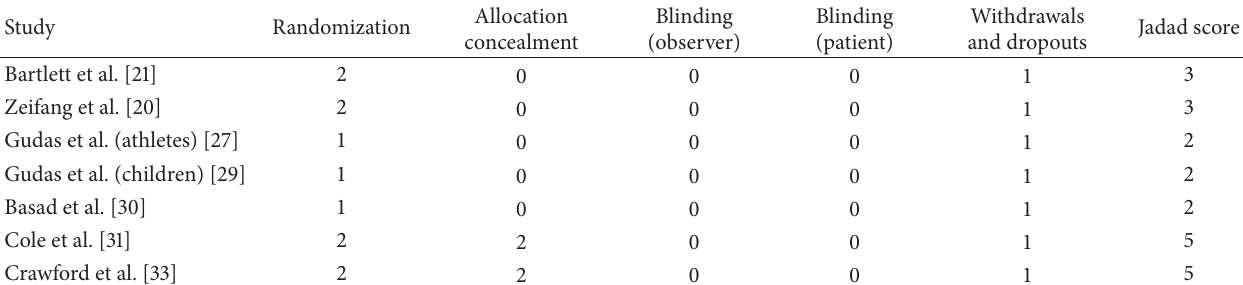
Table 5: Assessment of methodological quality of RCTs by using 7-point modified Jadad scoring system.